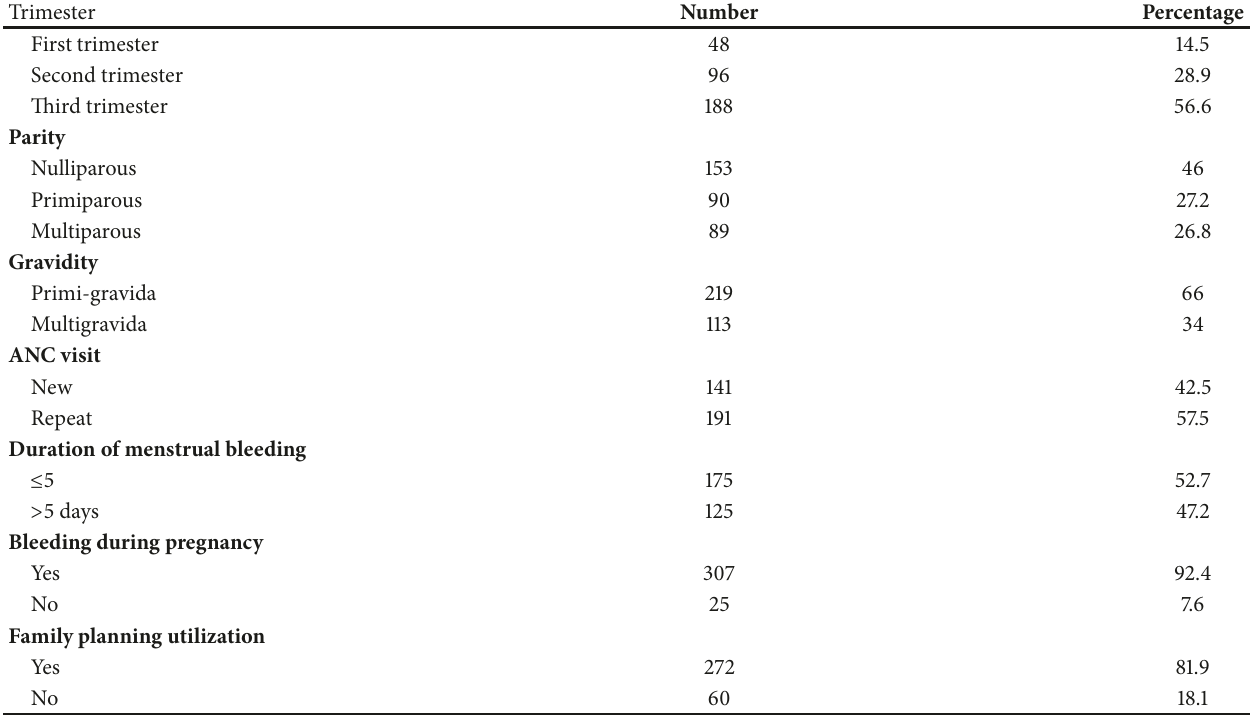
Table 2: Obstetric characteristics of pregnant women attending ANC at the University of Gondar Referral Hospital (n = 332). Trimester